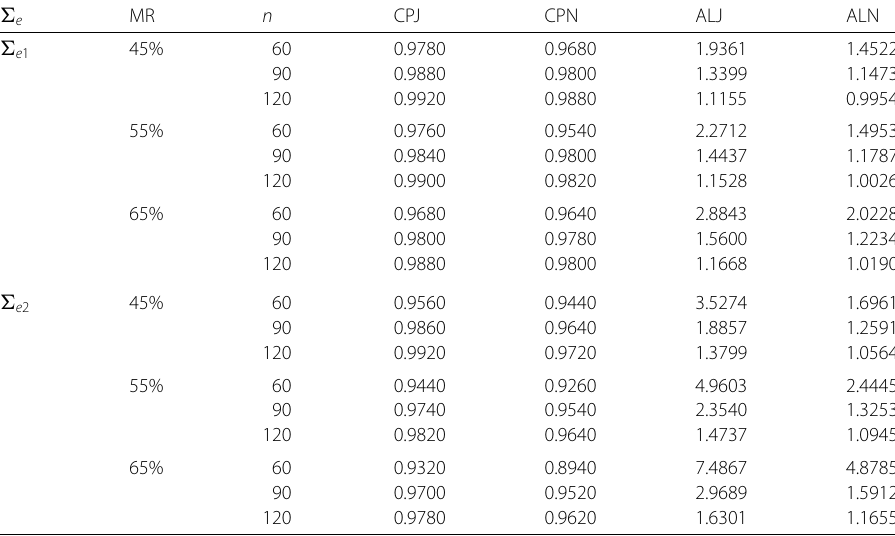
Table 4 CP and AL for JEL method and NA method on θ with confidence level